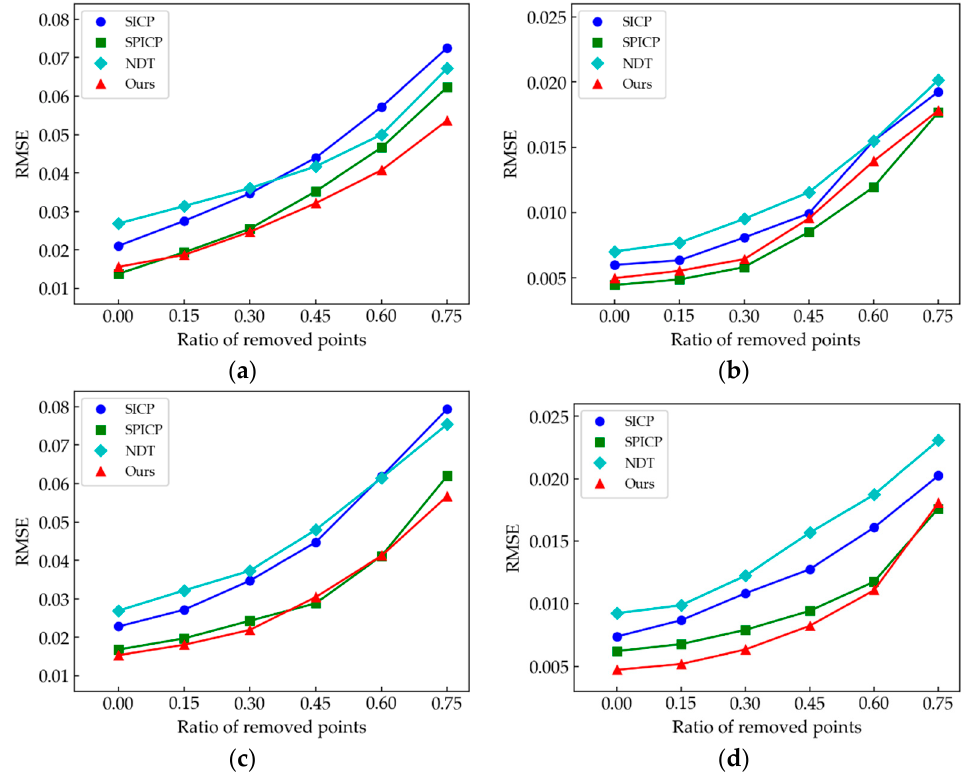
Figure 13. Evaluation of the impact of uniform down-sampling with different sampling densities on the four algorithms. ( a ) Comparison results of M 1 point cloud; ( b ) M 2 ; ( c ) M 3 ; ( d ) M 4 .